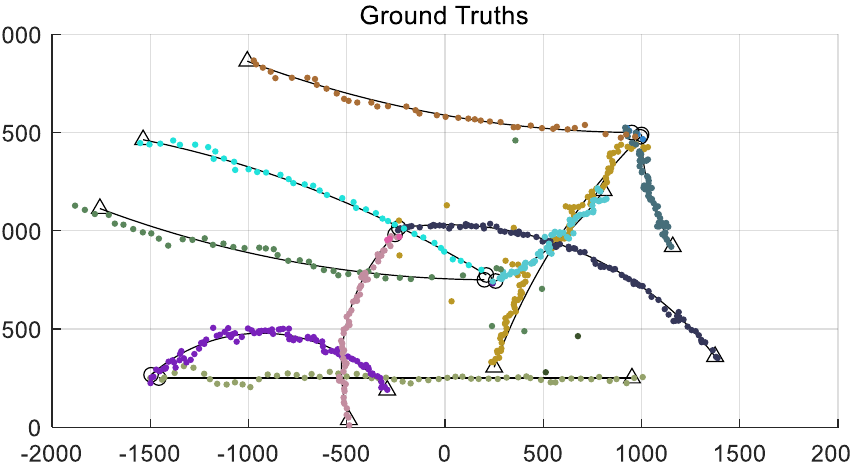
. Figure 4. Multiple-target trajectories in the x y − plane. Start/Stop positions for each track are shown with ○ / △ . And different colored lines represent different trajectories. In the following numerical simulations, to set the different low SNR values for the challenging scenario with multi-target tracking, let SNR be signal-to-noise ratio defined in dB as